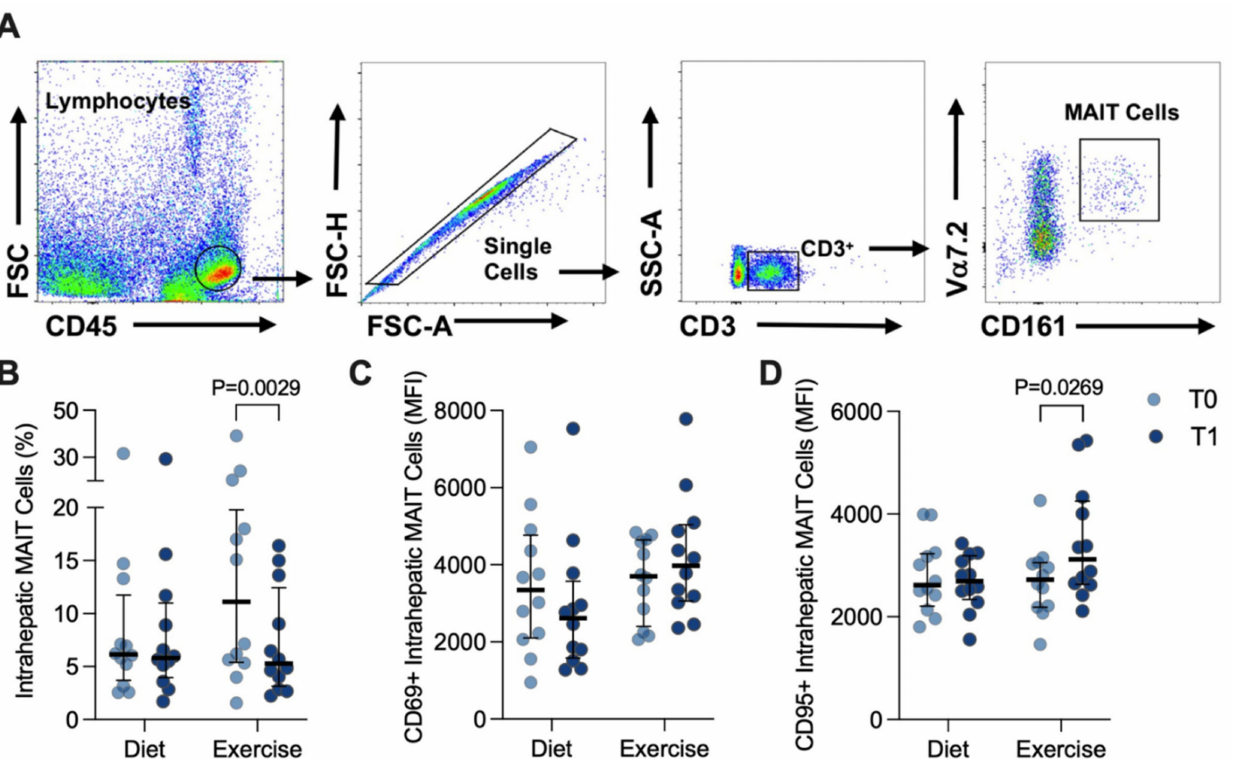
Figure 4. Intrahepatic MAIT cells before (T0) and after (T1) diet or exercise intervention. ( A ) Repre- sentative flow cytometry dot plots showing gating strategy for defining intrahepatic CD3 + V α 7.2 hi CD161 hi MAIT cells. ( B ) Intrahepatic MAIT cells in participants completing either 12 weeks of diet ( n = 12) or exercise ( n = 12) intervention. ( C ) CD69+ and ( D ) CD95+ circulating MAIT cells before and after intervention. Data were analysed via Wilcoxon matched pairs signed-rank test and individual values and median ± interquartile. MAIT: Mucosal-associated invariant